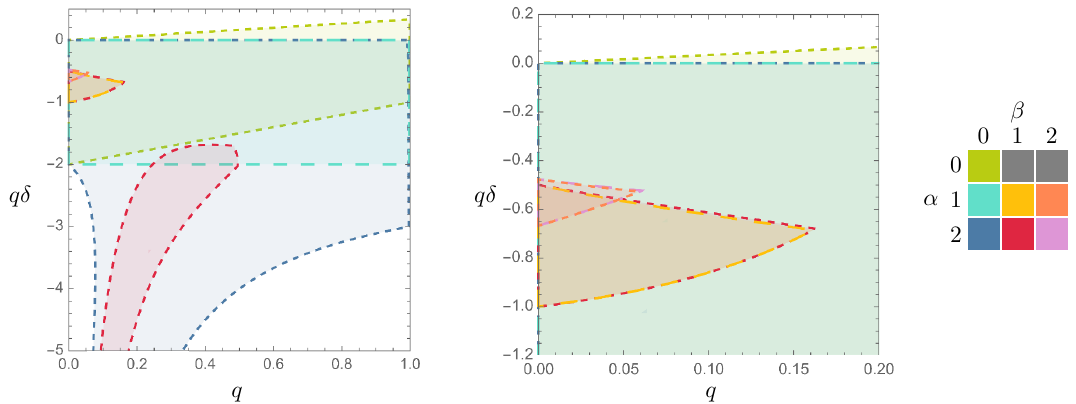
Figure 3 . Numerical plots depicting the parameter space for which all partial waves on all calculated residues are unitary. Positive regions are represented in the ( q, qδ ) plane for various choices of α, β ∈ { 0 , 1 , 2 } , all with γ = 0 and D = 4 . The cases ( α, β ) = (0 , 1) and (0 , 2) evidently do not support any consistent